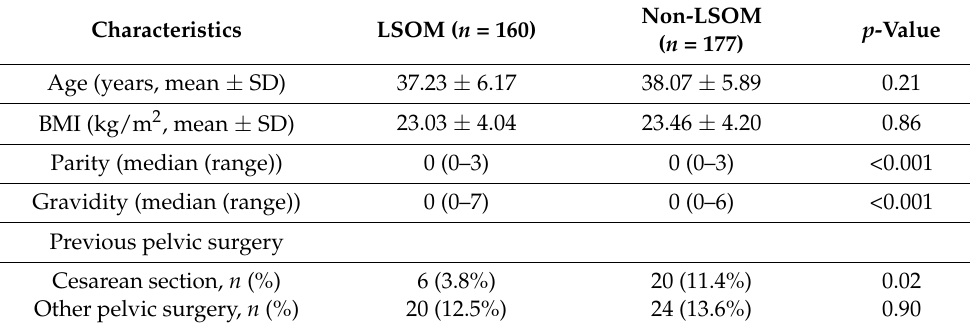
Table 1. Patient baseline characteristics.